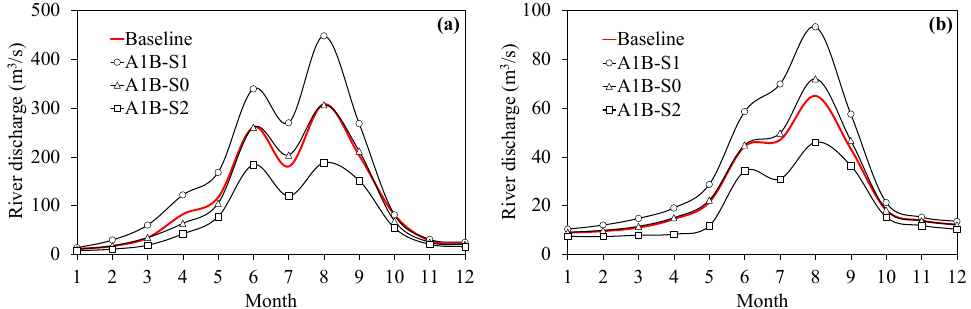
Figure 10. Estimated monthly river discharge under various future climate conditions in ( a ) the Choushui River, and ( b ) Beigang River catchments.